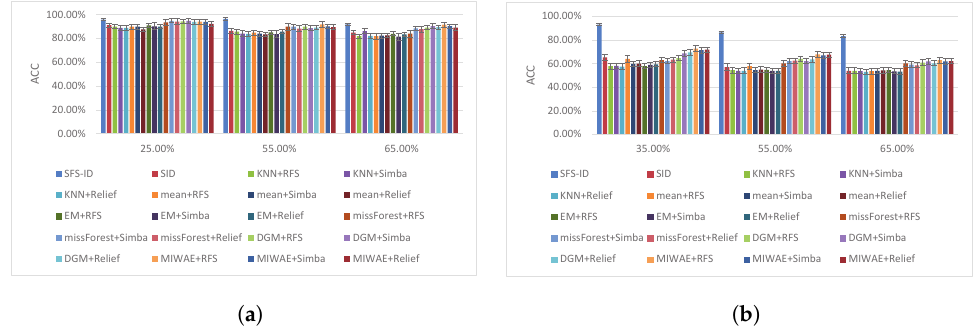
Figure 7. Accuracy under different missing ratios for USPS and Arcene datasets. ( a ) USPS. ( b )